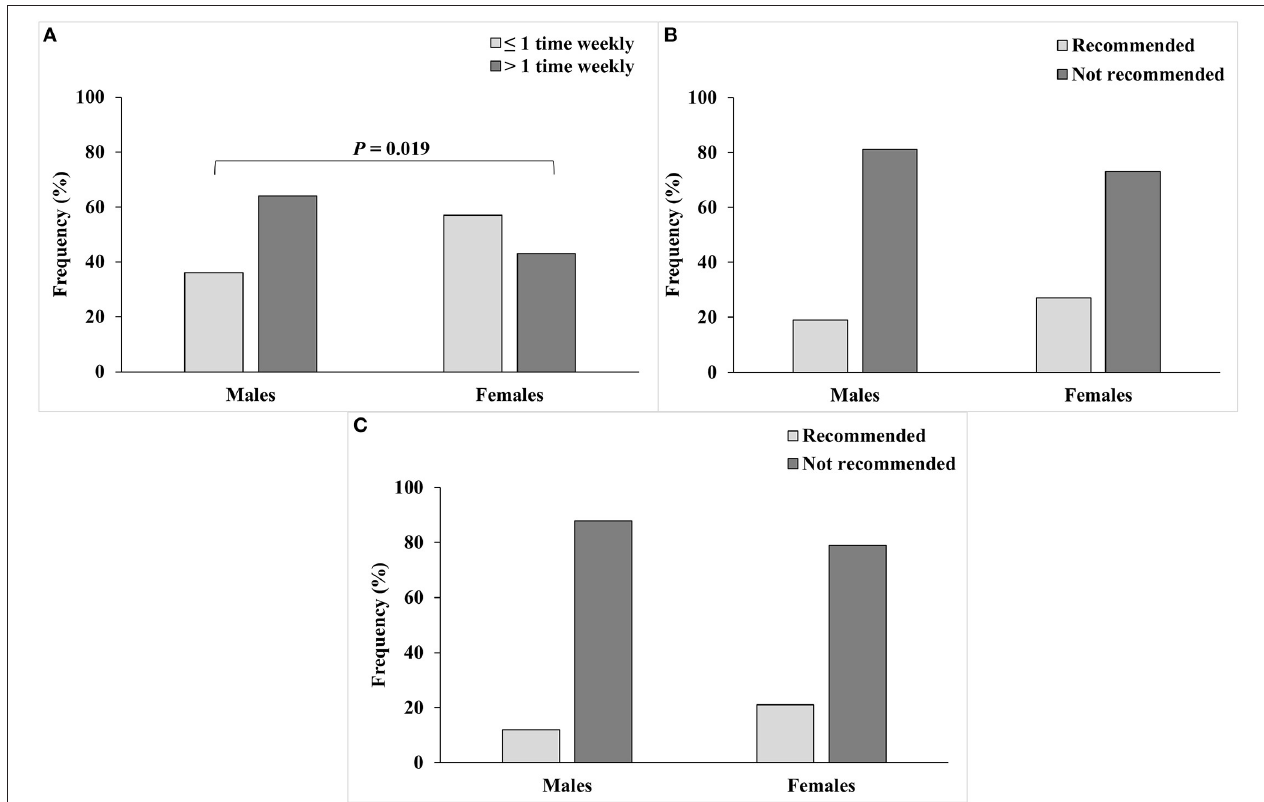
FIGURE 4 | Dietary intake for male and female college students from (A) Fast food, (B) Fruits; 4 servings per day for both genders is recommended, and (C) Vegetables; 5 servings per day for females and 6 servings per day for males are